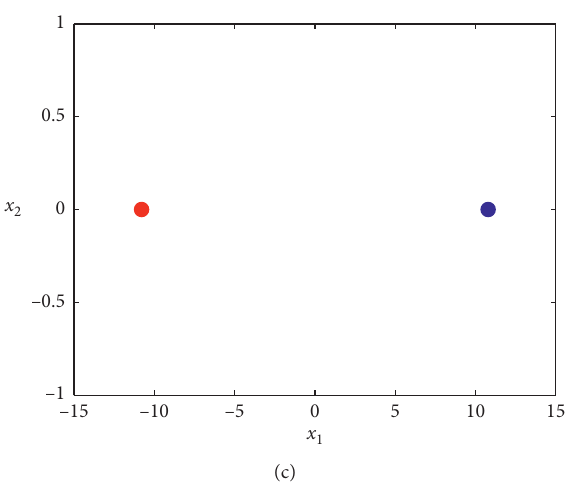
Figure 16: Coexistence of six different attractors (a pair of symmetric period-2 limit cycle, a pair of symmetric period-9 limit cycle, a pair of symmetric chaotic attractors, and a pair of point attractors). The values of others system parameters are fixed as follows: a � 1 . 8, b � 3 . 8, d � 1 . 35, e � 14 . 85, and m � 2 . 2. Initial conditions are given in Table 4.